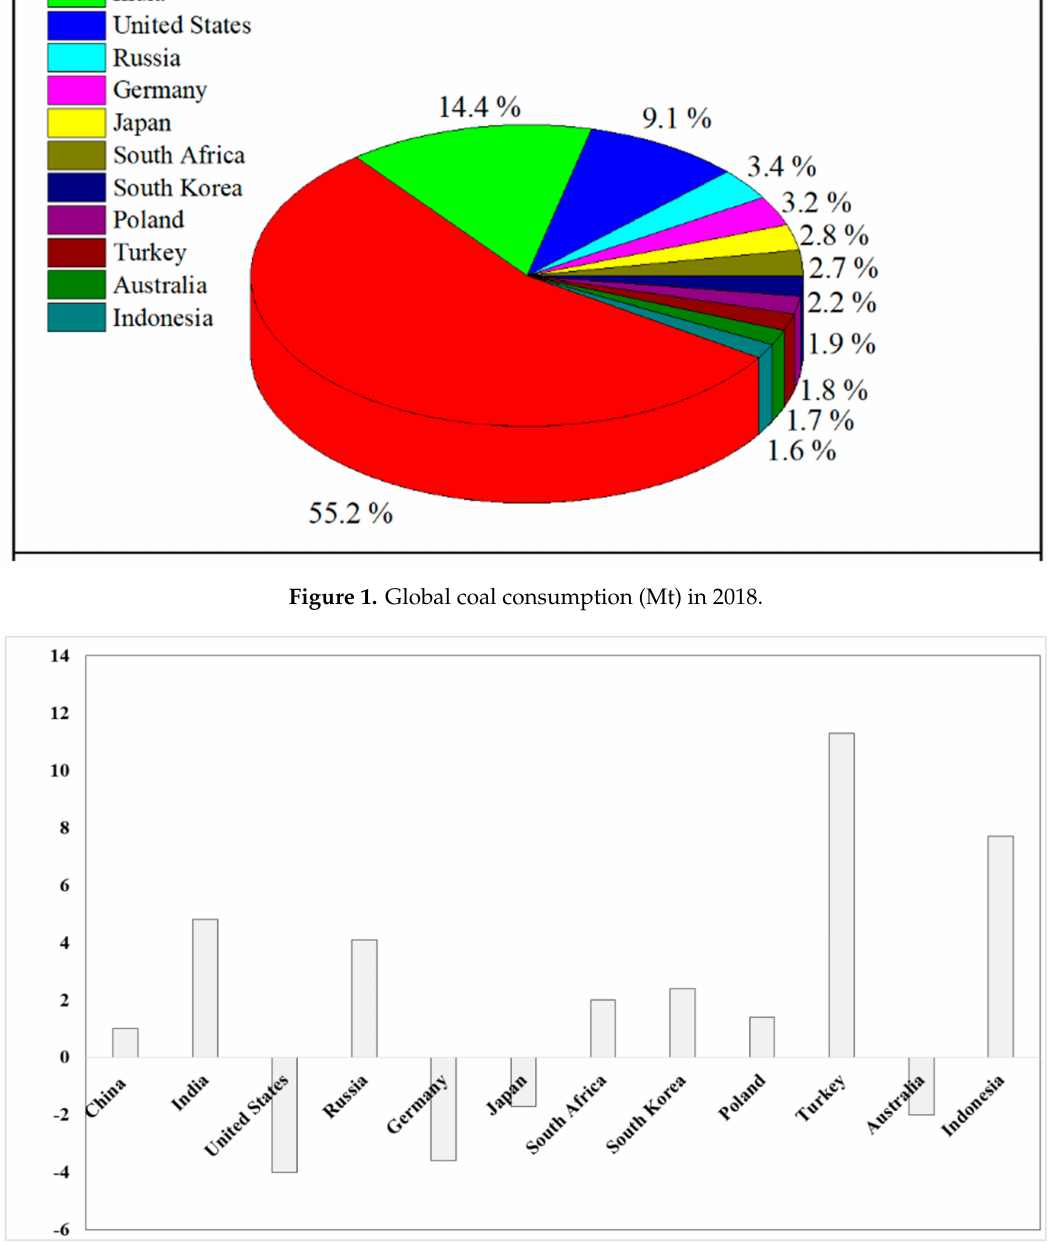
Figure 2. Coal consumption trend (%) in